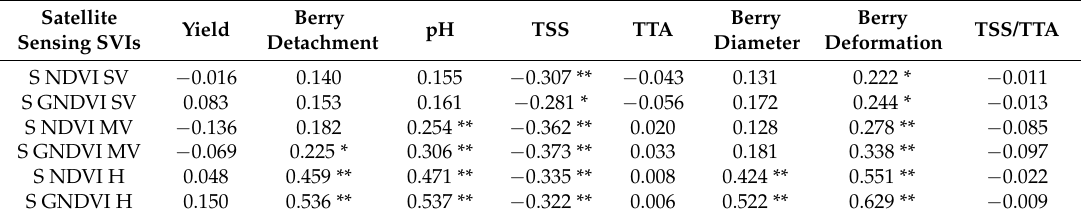
Table 6. Pearson’s correlation matrix between the satellite-based spectral vegetation indices and the table grape yield and quality characteristics at different crop